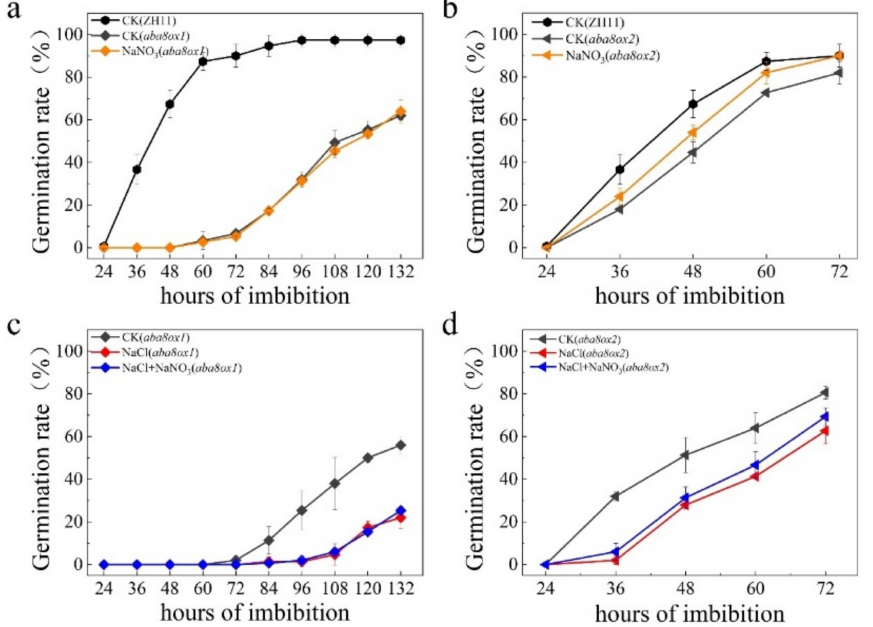
Figure 7. Effect of nitrate on ABA catabolism defective mutants during seed germination under salt stress. ( a , b ), Effect of 1 mM NaNO 3 on seed germination of three mutants of ABA catabolism gene, aba8ox1 and aba8ox2 ; ( c , d ), Seed germination of aba8ox1 and aba8ox2 under treatments of NaCl and